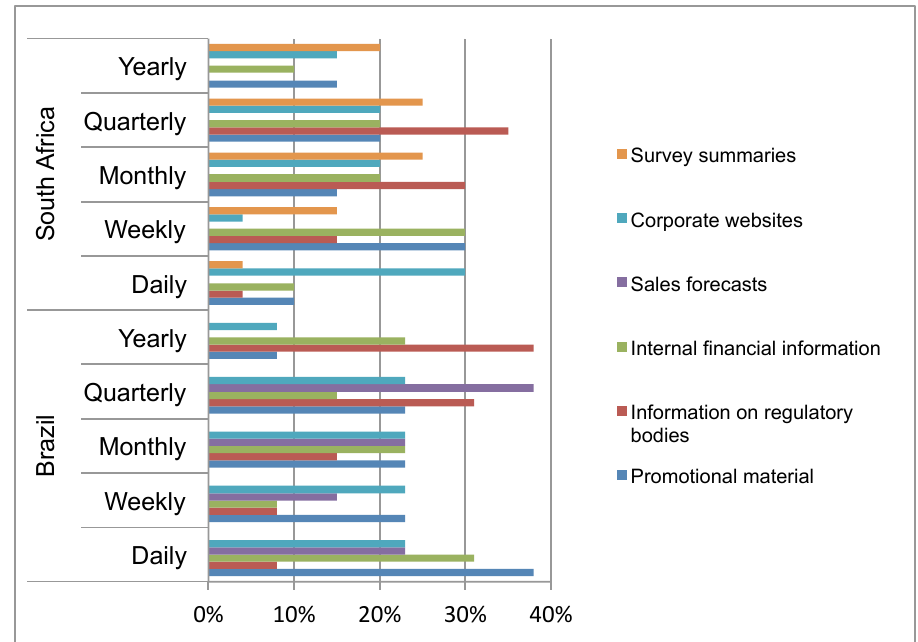
Figure 2: Use of secondary